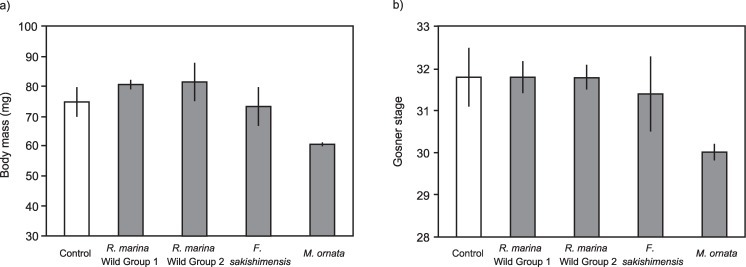
Growth and development of tadpoles of the Ornate Narrow Mouthed Frog M. ornata at day 10 day following exposure as embryos to chemical cues of older Cane Toad tadpoles (Wild Group 1 and 2) and native frog tadpoles (F. sakishimensis and M. ornata).The panels show impact of exposure to tadpoles on a) body mass, and b) developmental stage (Gosner 1960 [38]) of Ornate Narrow Mouthed Frog embryos. The graphs show mean values with associated standard errors.